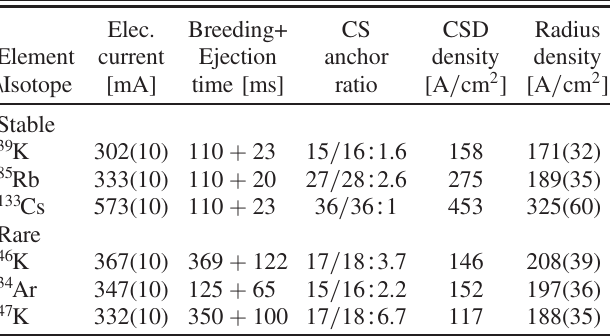
TABLE IV. Density (effective) of the electron beam for differ- ent electron currents estimated from experimental charge-state distributions (CSD density) using CBSIM with fixed charge- state anchors. These estimates are compared with the density calculated from the measured electron-beam radius (Radius density)